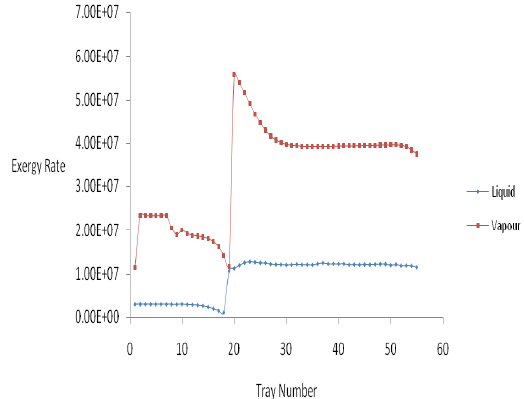
Figure 17. Profile of exergy rate versus tray number for Depropanizer of base case, 80 o C, Reflux Ratio 2